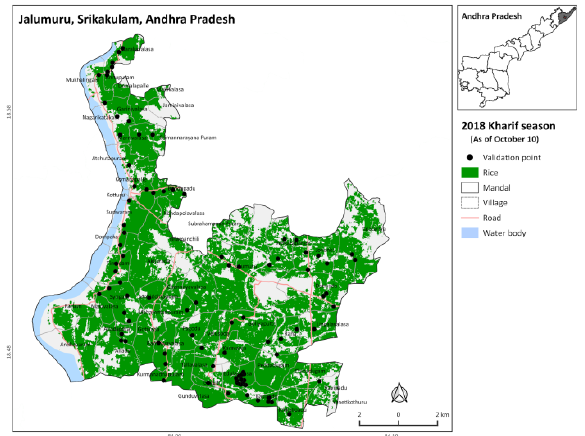
Figure 2. Rice area estimates in Jalumuru mandal, Srikakulam district with validation points, 2018 kharif , 10 October 2018.